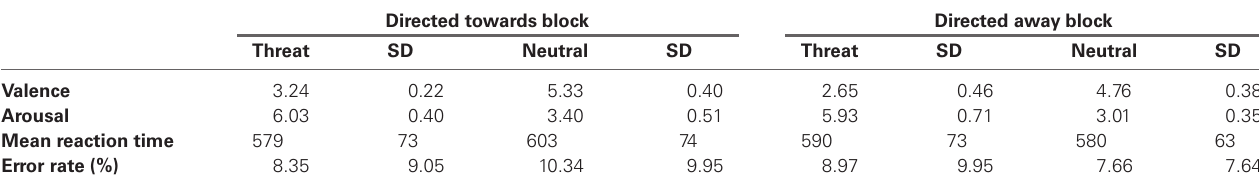
Table 1 | Mean valence, arousal, reaction time and error rate for neutral and threat